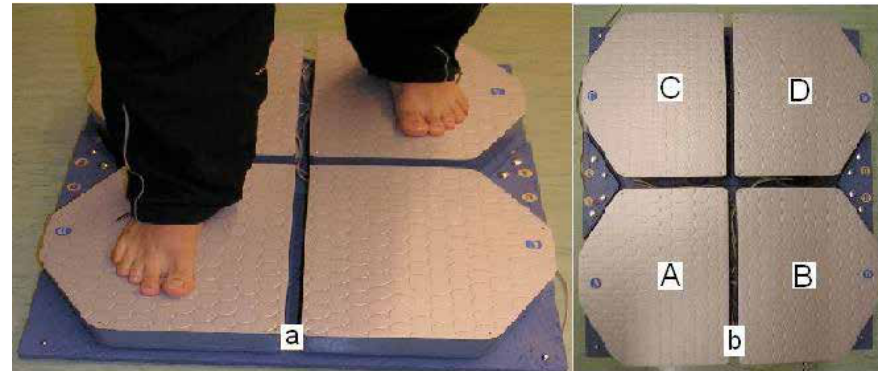
Figure 1. Two twin platforms kinesis-meter CQStab2P used for measurements [16]: testing in A–D feet situation (a), plates − sight from above